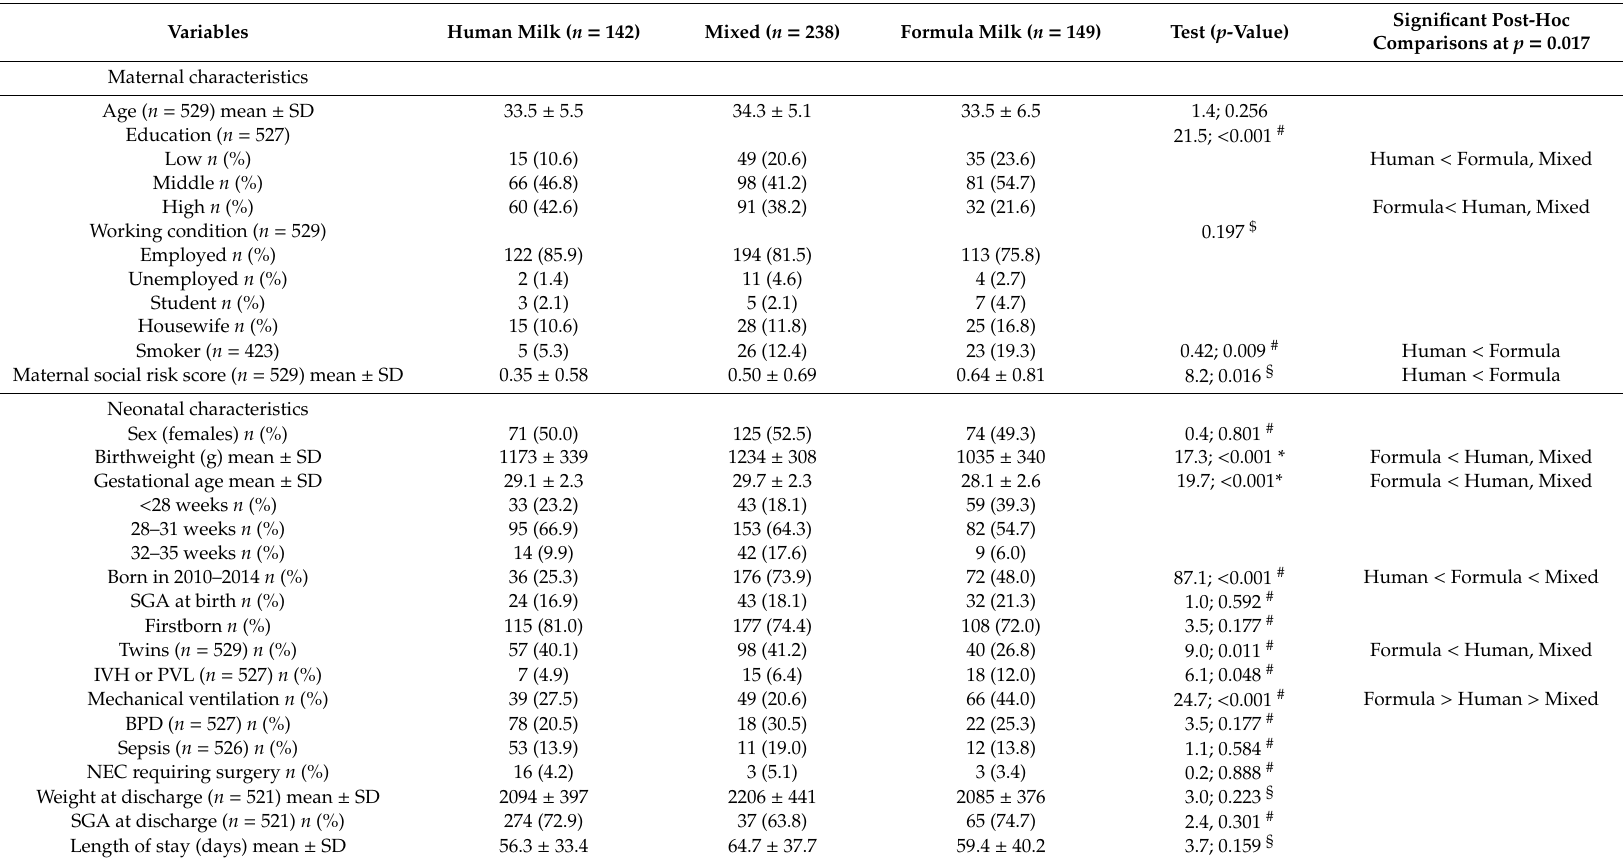
Table 2. Characteristics of the study population by diet at